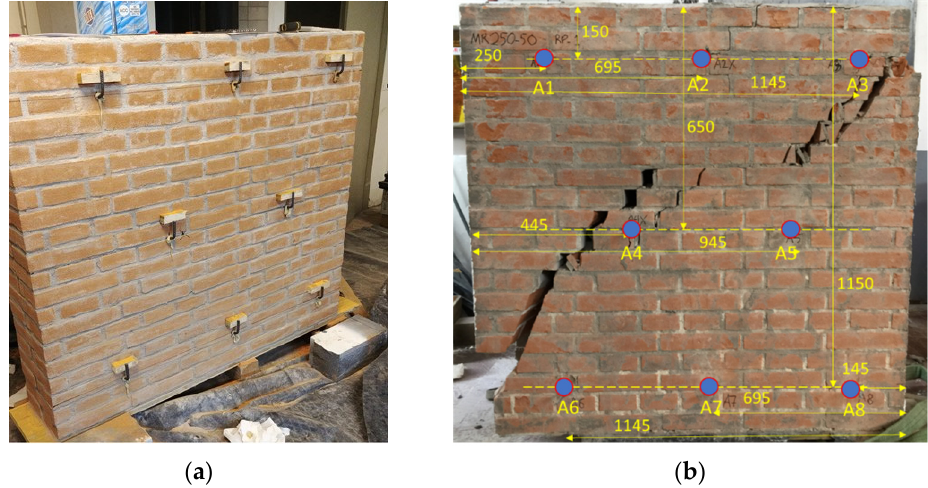
Figure 1. Anchor position within the wall after installation ( a ) and after damage ( b ) (dimensions in mm).